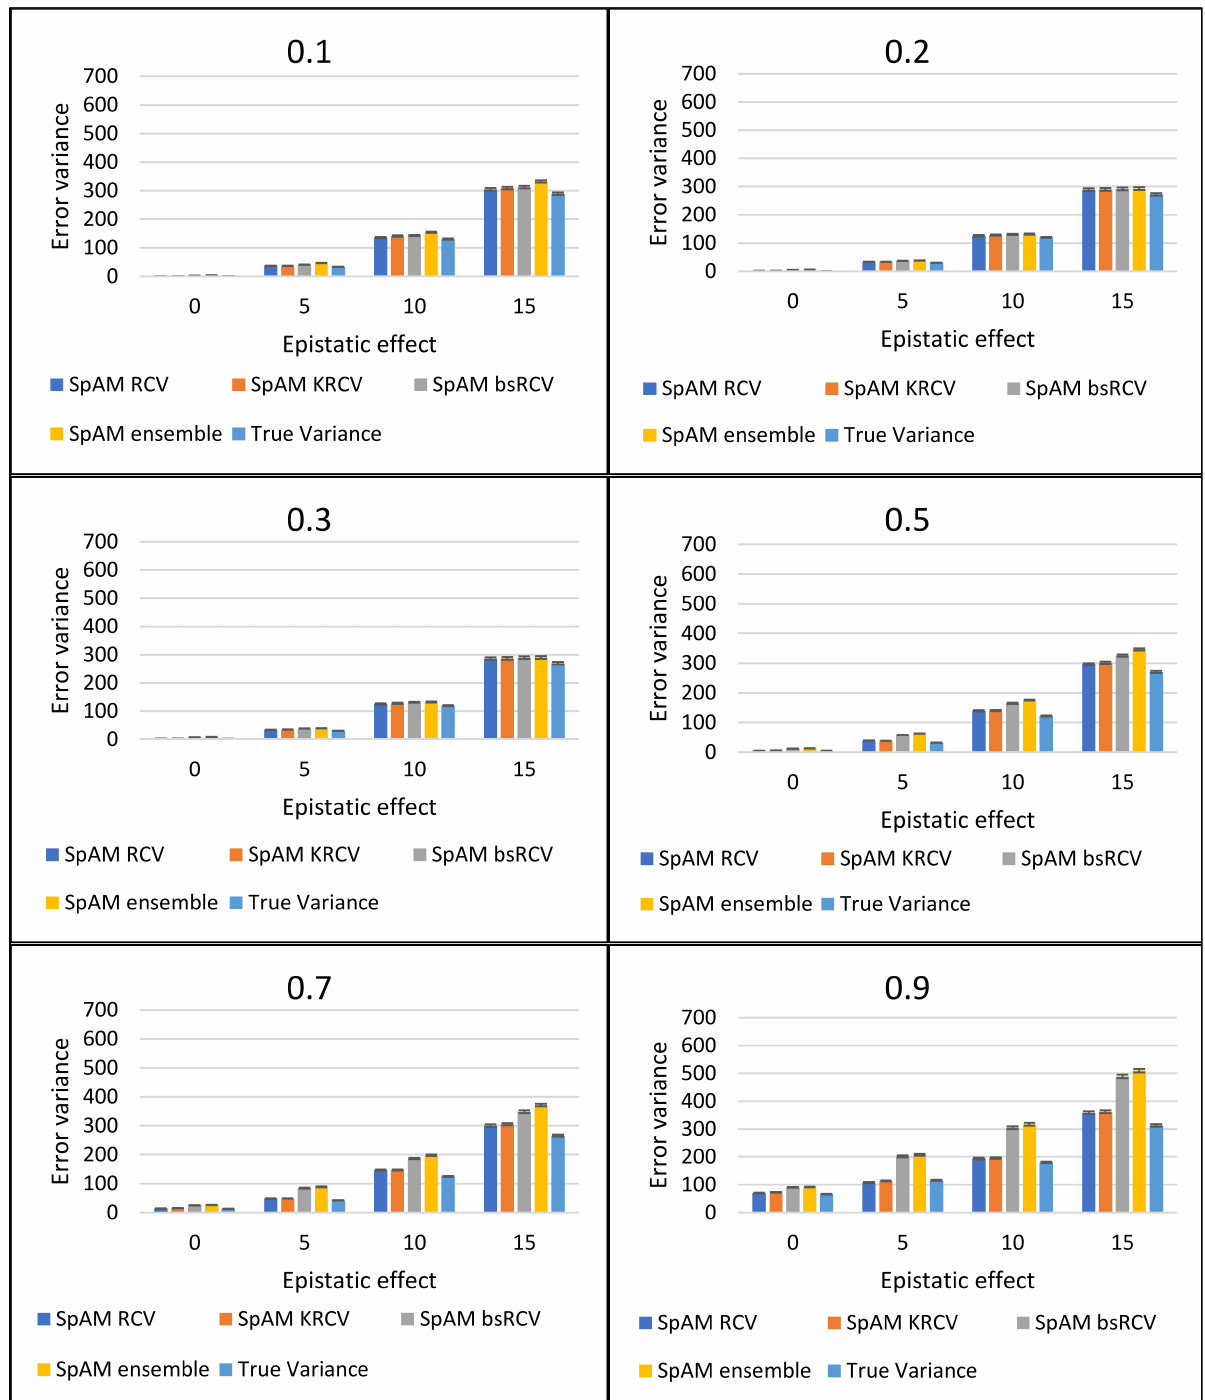
Figure 5. Comparison of RCV, k-RCV, bs-RCV and Ensemble method for SpAM. RCV: Refitted Cross Validation, k-RCV: kfold Refitted Cross Validation, bs-RCV: Bootstrap RCV, SpAM: Sparse Additive